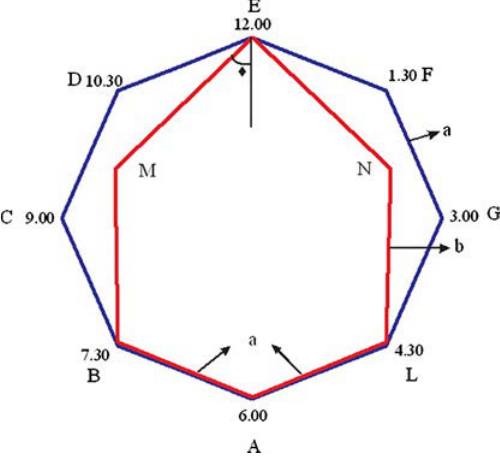
Figure 7 Comparison of the cross-sectional area between the standard sphincterotomy (ABMENL, shown in red) and radial sphincterotomy (ABCDEFGL, shown in